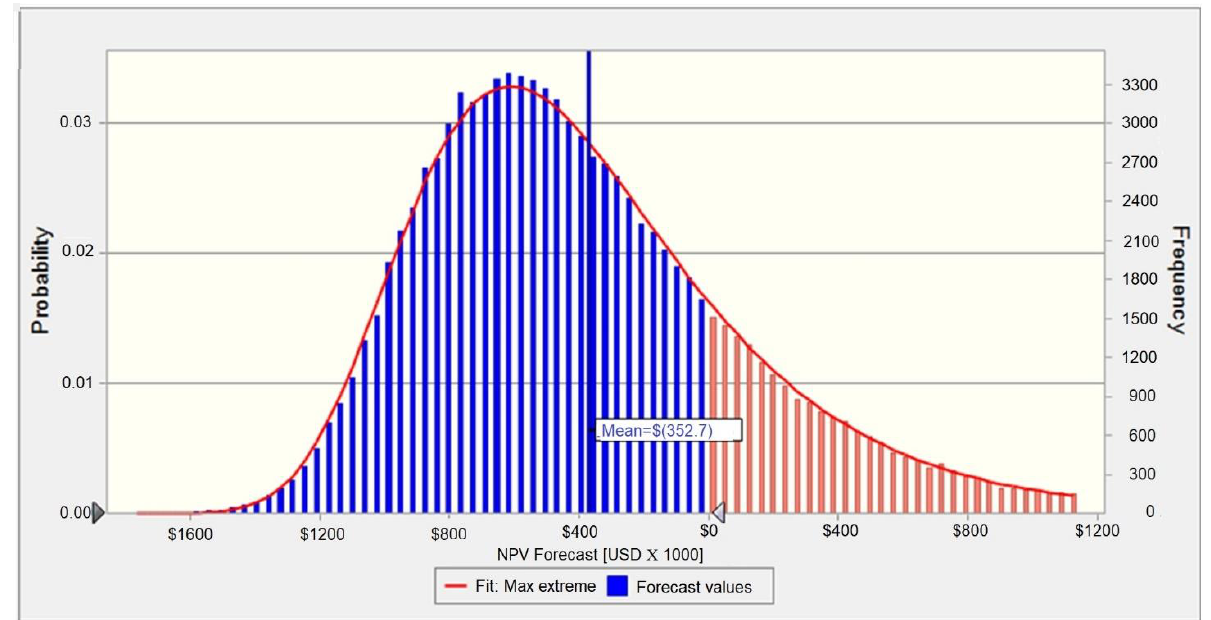
Figure 13. NPV forecast of the gas microturbine and downdraft gasifier-based generation system using oxygen-enriched air as a gasification agent.